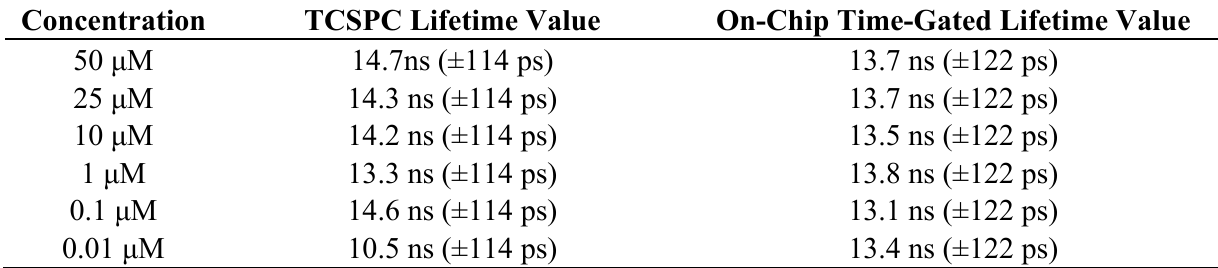
Table 3. Extracted lifetime values for quantum dot samples of varying concentration, processed using external TCSPC hardware and on-chip time-gated